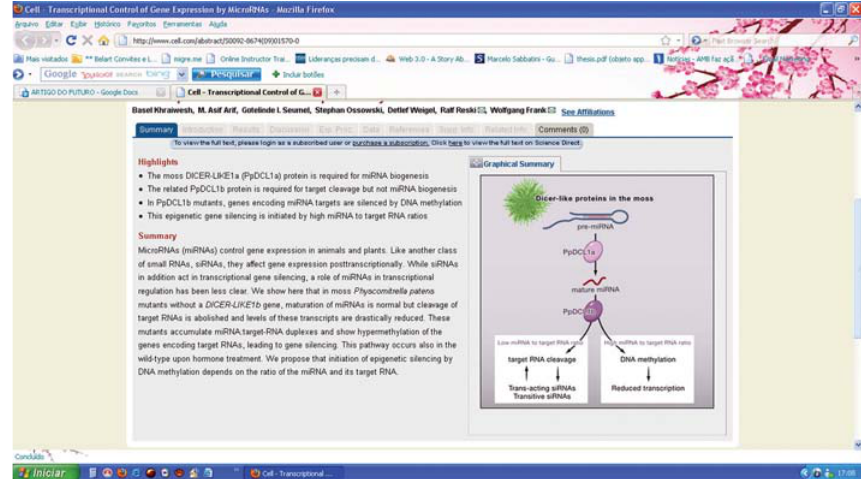
Fig.1 - Página da Cell, com o artigo